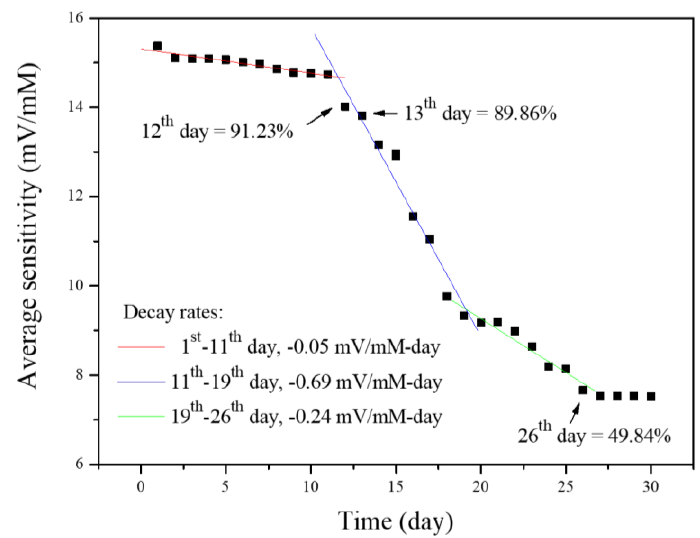
Figure 13. Average sensitivity variation of the potentiometric arrayed glucose biosensor based on Nafion-GOx/GO/AZO through a month.